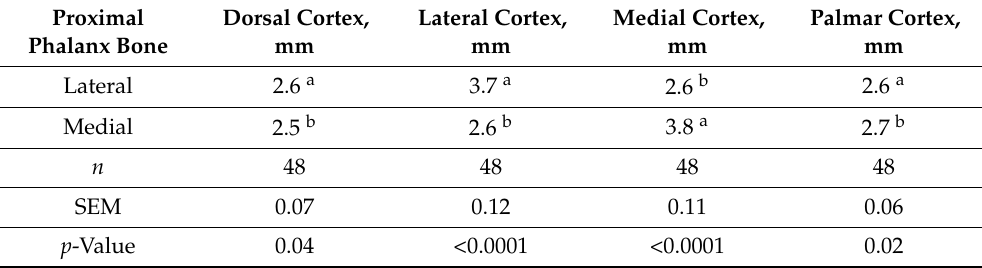
Table 6. Cortical widths of the lateral and medial proximal phalanx of left and right front